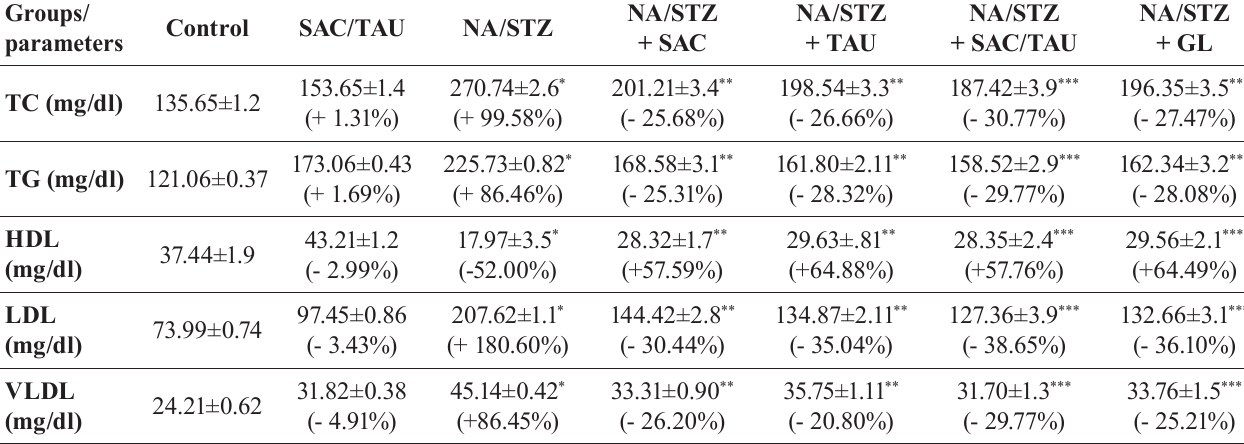
TABLE II - Effect of SAC, TAU and SAC/TAU treatment on lipid profile in T2DM animals Groups/